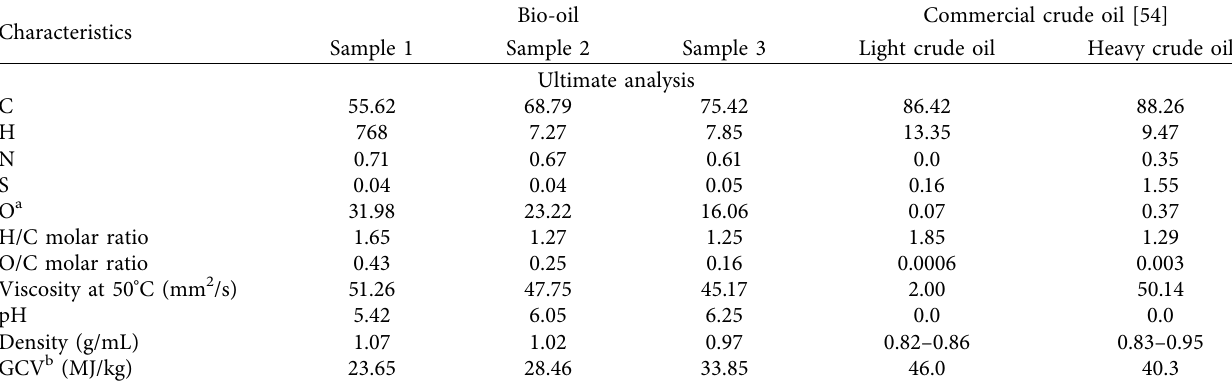
Table 4: Characteristics of bio-oils obtained without catalyst and by using 13X zeolite and Fe-Cu/13X zeolite catalysts. Characteristics